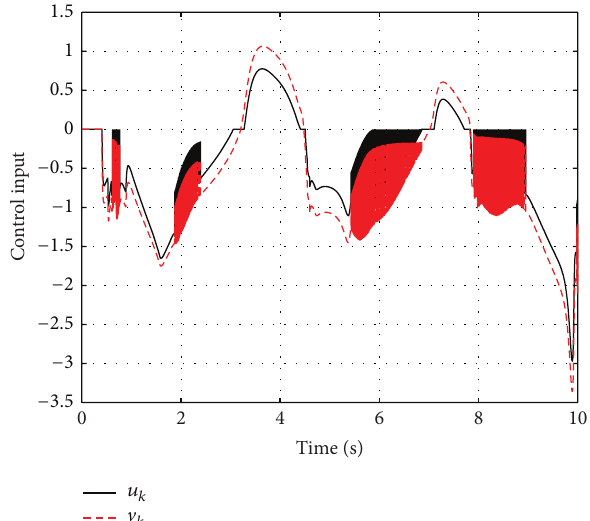
Figure 10: Control input 𝑢 𝑘 and V 𝑘 (𝑘 = 10) in Case 2.